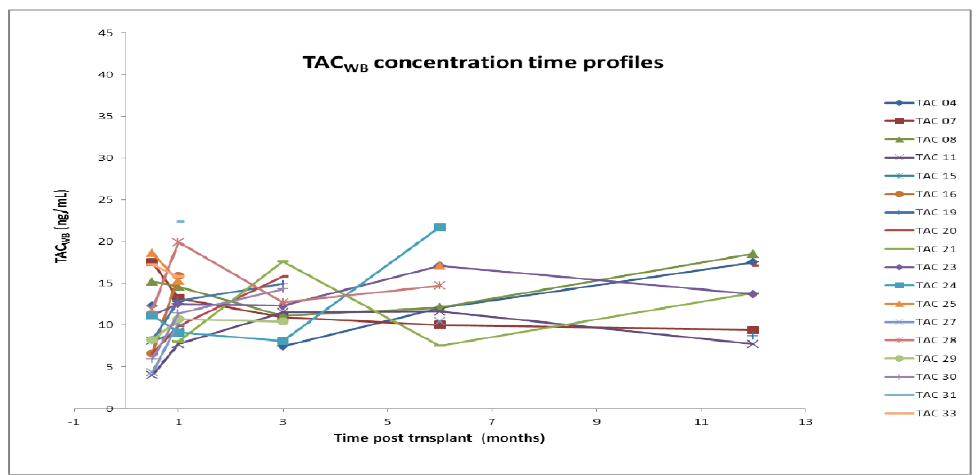
Figure 3. Concentration–time profiles of TAC in whole blood (18 patients). TAC: Tacrolimus; WB: whole blood.